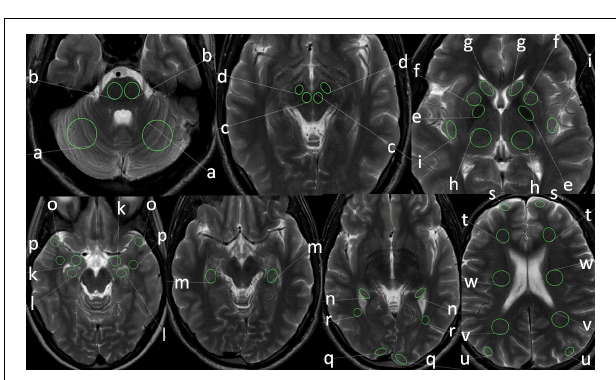
FIGURE 2 | Positions and sizes of ROIs in different anatomical locations: cerebellar hemispheres (a), pons (b), red nucleus (c), substantia nigra (d), putamen (e), globus pallidus (f), head of caudate nucleus (g), thalamus (h), insular cortex (i), amygdala (k), head of hippocampus (l), body of hippocampus (m), tail of hippocampus (n), temporal cortex (o), temporal white matter (p), occipital cortex (q), occipital white matter (r), frontal cortex (s), frontal white matter (t), parietal cortex (u), parietal white matter (v), white matter of centrum semiovale (w).